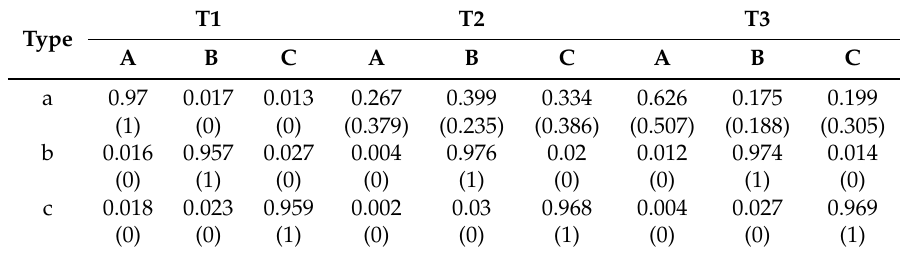
Table 5. Observed frequencies of voting by type (equilibrium predictions in